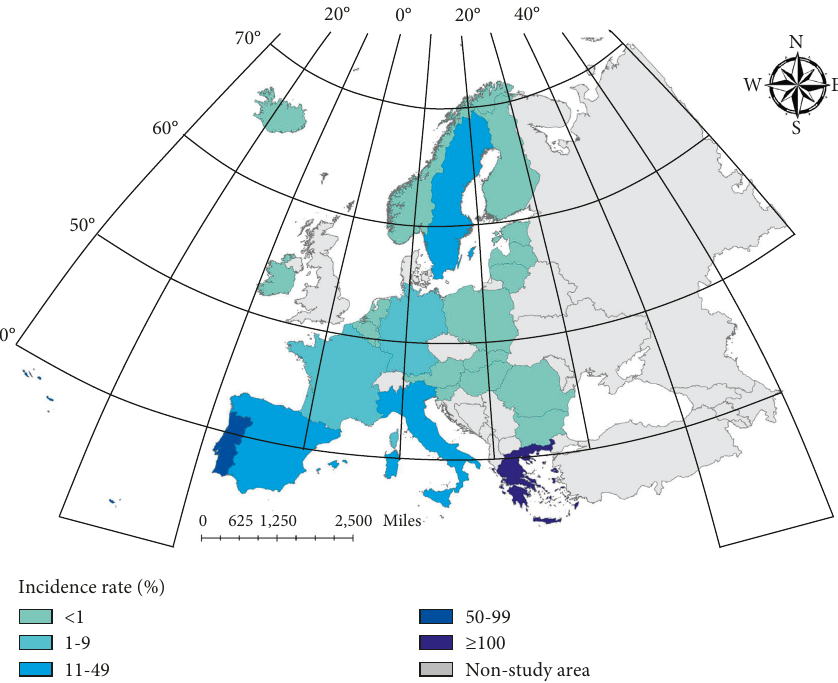
Figure 11: Spatial distribution of prediction data